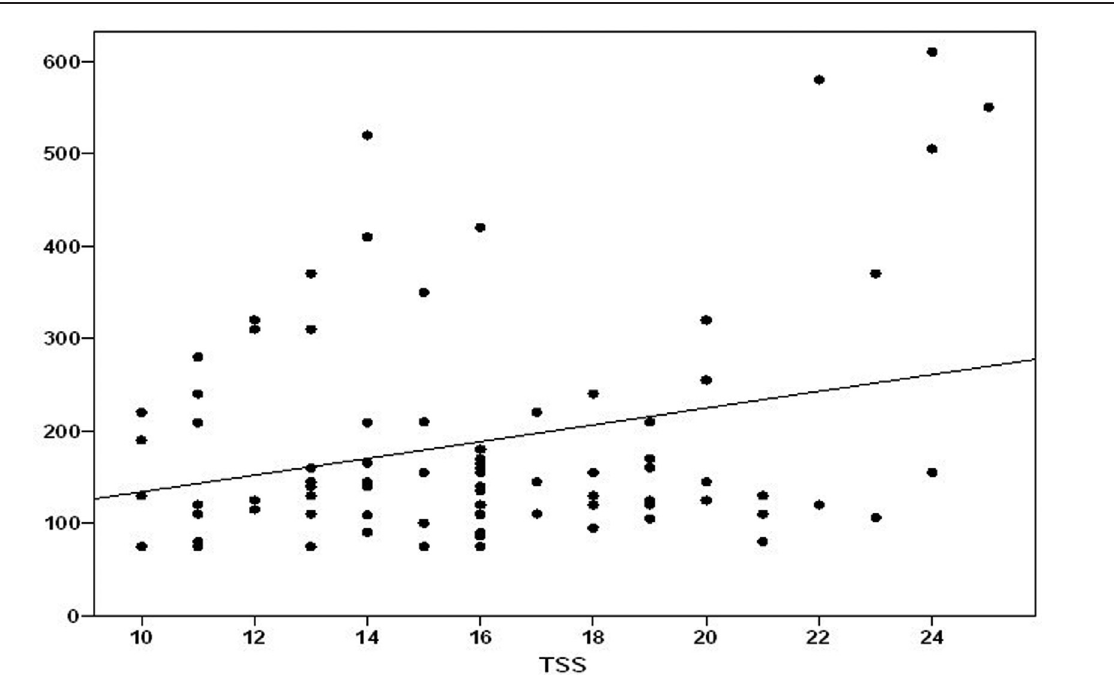
Table 3 Outcome of the first session of therapy Data